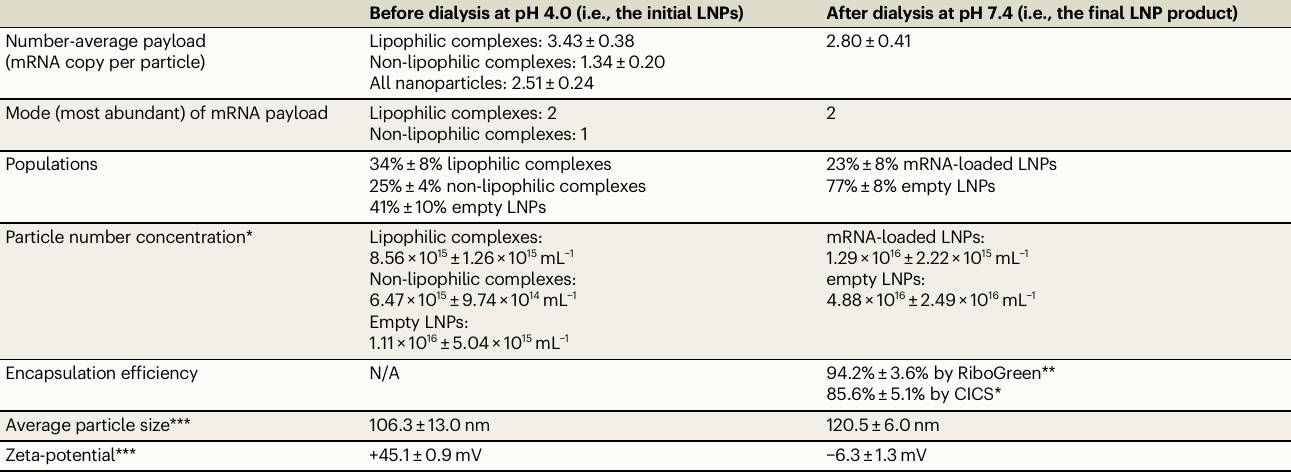
Lipid composition: DLin-MC3-DMA:cholesterol:DSPC:DMG-PEG2000=50:38.5:10:1.5. *Thecalculationsfor theseparametersfromCICSdata are detailed in SupplementaryDiscussion 2 – 5; **Theassayisdescribed inMethods; ***Theparticlesizeisreportedasz-averagediameterassessedbydynamiclightscattering(DLS),thatcountedallemptyormRNA-loadedLNPs.Thezeta-potentialwasassessedbyphaseanalysis